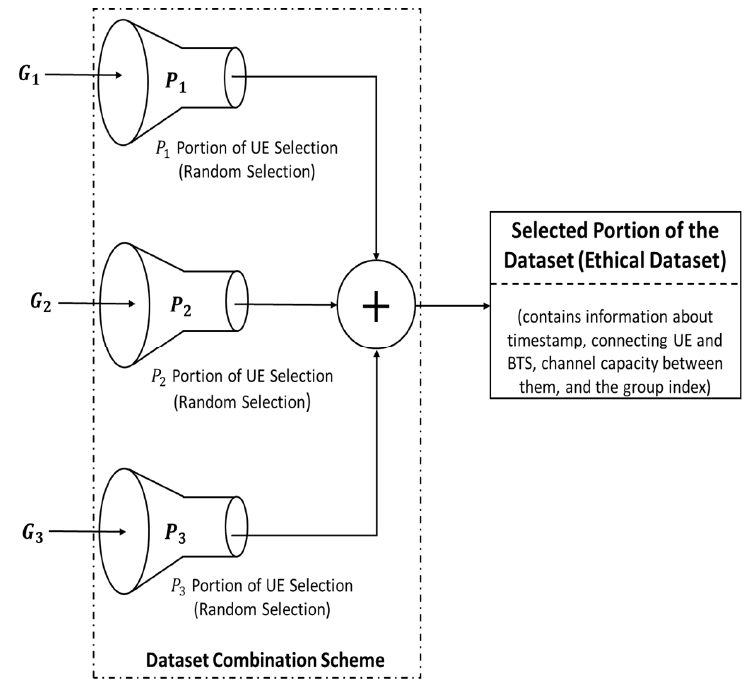
Figure 3. A general wireless system dataset combination scheme.